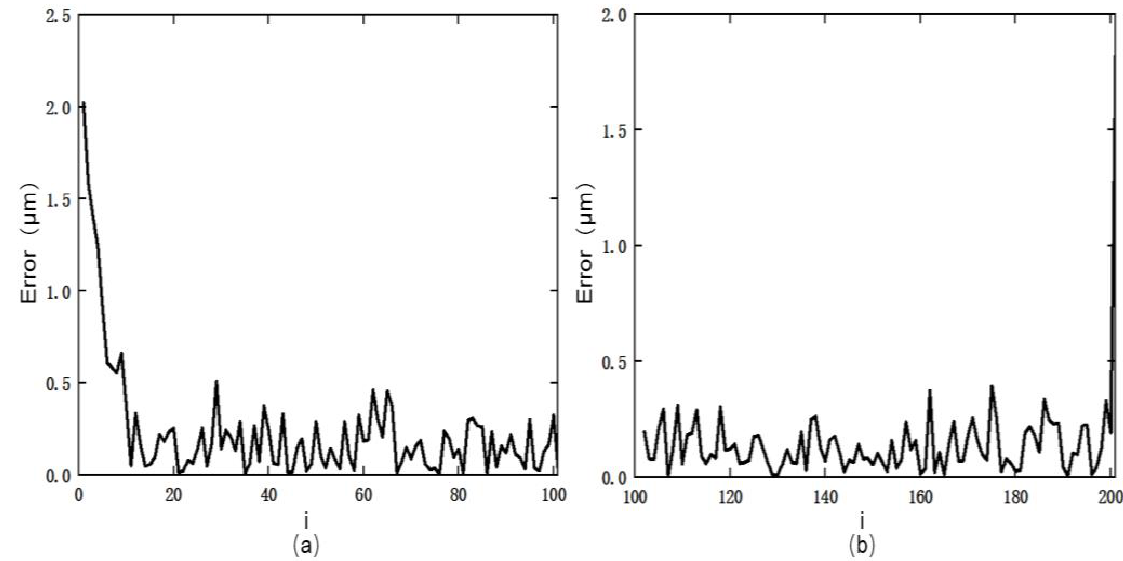
Figure 9. Fitting error diagram of model data and experimental data: ( a ) ascending segment; ( b ) descending segment.